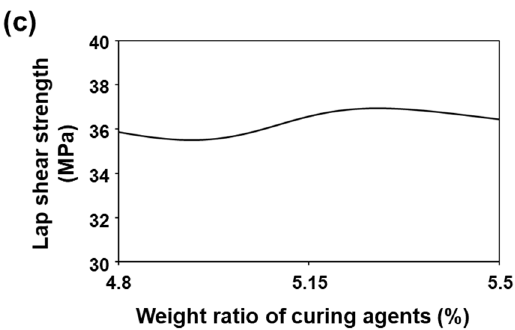
Figure 6. Prediction of the lap shear strength by the change in the weight ratio of the ( a ) catalyst, ( b ) flexibilizer, and ( c ) curing agents.